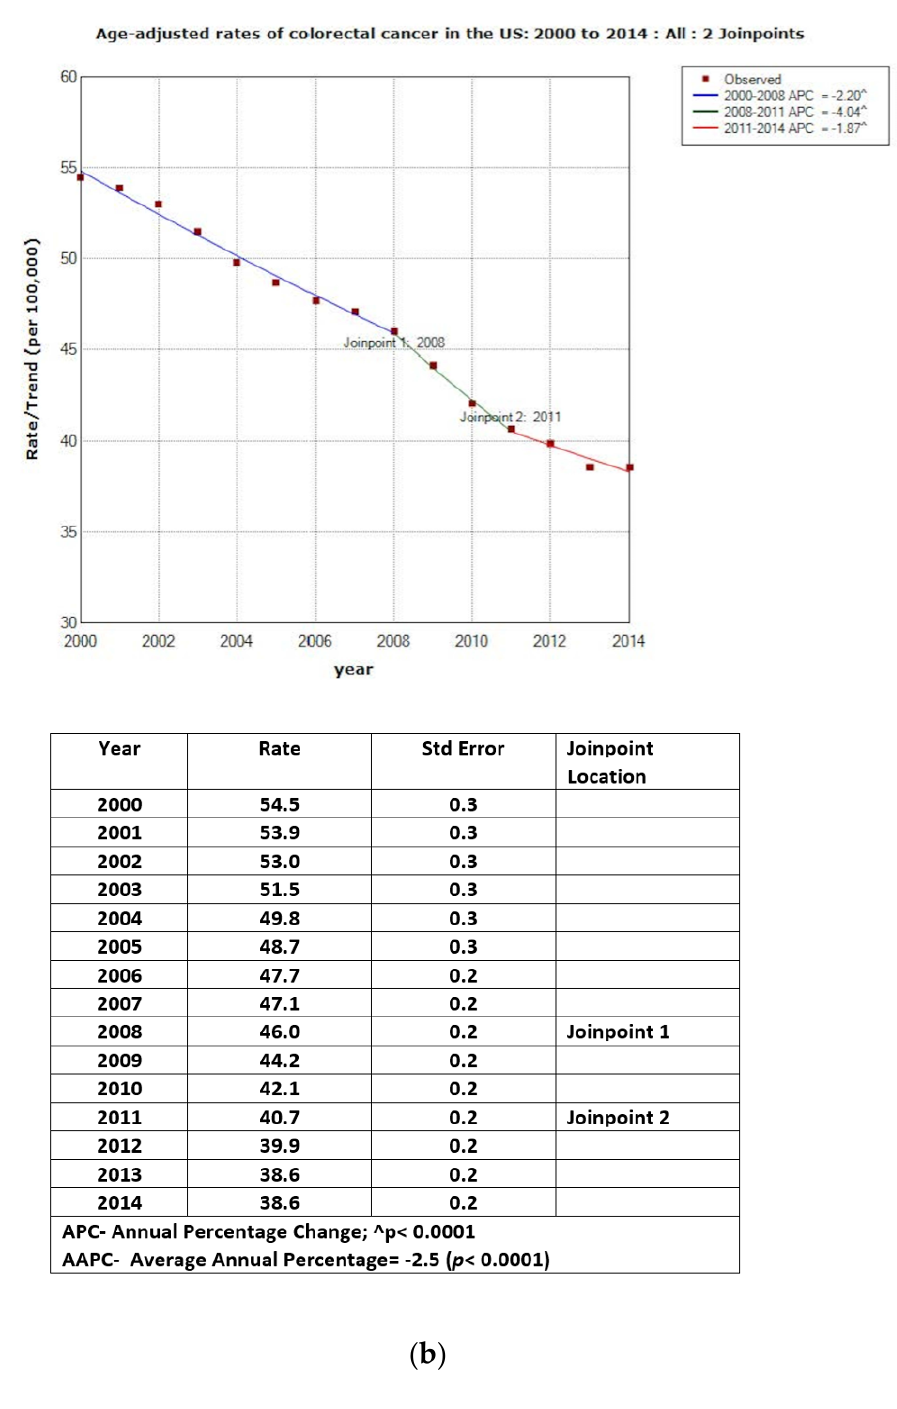
Figure 1. ( a ) Age-adjusted rates of colorectal cancer in USA: 2000–2014: All: 0 Joinpoints. ( b ) Age-adjusted rates of colorectal cancer in USA: 2000 to 2014: All: 2 Joinpoints.